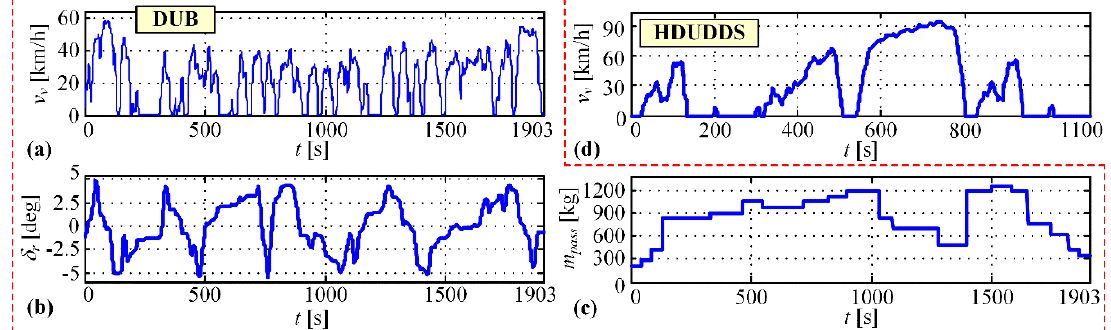
Figure 4. Time profiles of ( a ) vehicle velocity, ( b ) road grade and ( c ) bus passengers mass for city-bus recorded driving cycle DUB and ( d ) speed time profile of Heavy Duty Urban Dynamometer Driving Schedule driving cycle (HDUDDS) assuming zero road grade and no passengers in the bus.